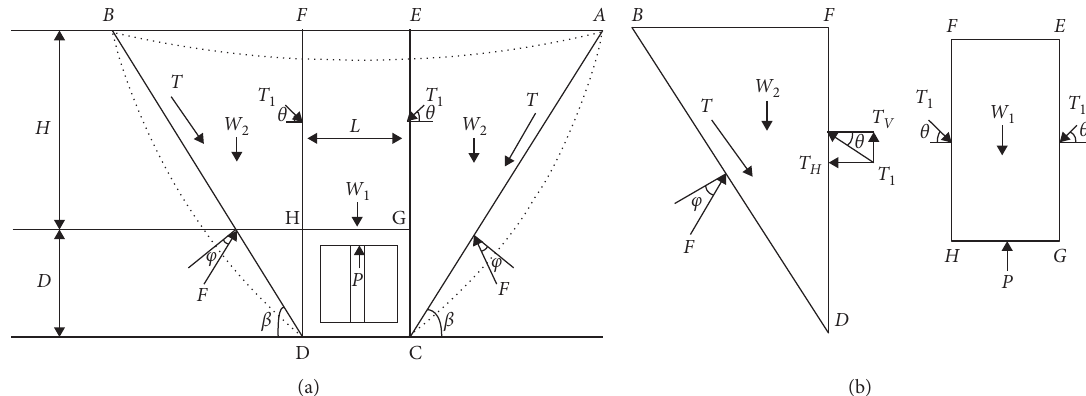
Figure 10: Calculation model of the surrounding pressure of the utility tunnel under ground fissure environment. (a) Structural disk force mode. (b) Force diagram of BFD and FEGH.